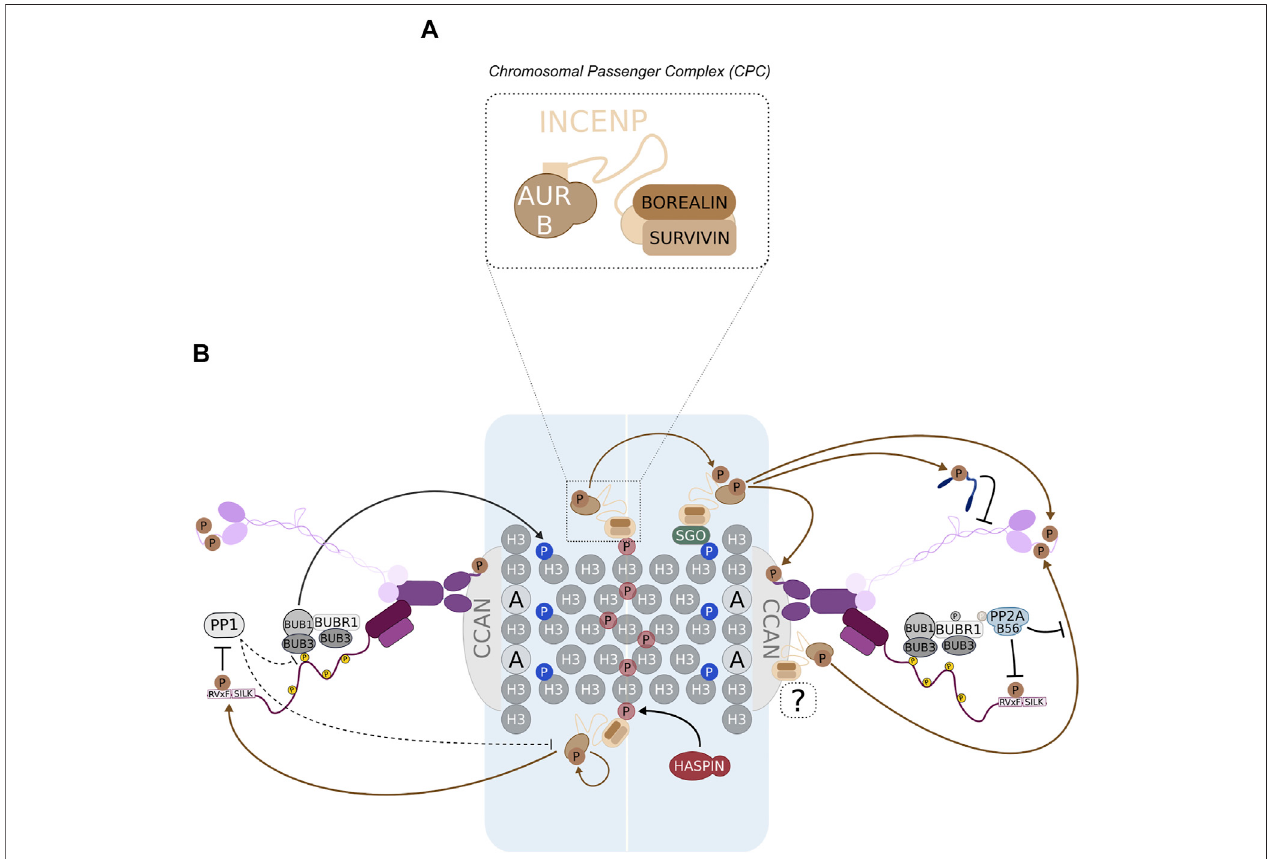
FIGURE 2 | AURORA B localizes at multiple sites along the centromere-KT axis. (A) AURORA B kinase associates with INCENP, BOREALIN and SURVIVIN to assemble the chromosomal passenger complex (CPC). (B) The conspicuous centromeric localization of the CPC relies on the interaction of SURVIVIN and BOREALIN with either inner centromeric phospho-H3-Thr3 or KT-proximal SHUGOSHIN1/2 (SGO), respectively. H3-Thr3 is phosphorylated by HASPIN, while KNL1-associated BUB1 phosphorylatesH2A-Thr120 torecruit SGO(notethatnucleosomesarerepresentedeitheras “ H3 ” or “ A ” todistinguish betweencanonical H3-orCENP-A- containing nucleosomes). It has also been proposed that a pool of AURORA B is present at KTs, although the KT receptor for this pool remains unknown ( “ ? ” ). Importantly,theprominentaccumulationofCPCatcentromeressupportspromptactivationofAURORABthrough trans auto-phosphorylation.Additionally,AURORAB phosphorylates INCENP tofully activate the CPC complex. Active centromeric and KTAURORA Bphosphorylate critical substrates with keyroles inKT-MT attachment stabilization, namely the NDC80c (N-terminal tail in NDC80), the SKAc and KNL1 (PP1-docking motif). The activity of AURORA B is likely counteracted by PP2A:B56 during early mitotic stages and by PP1 at later